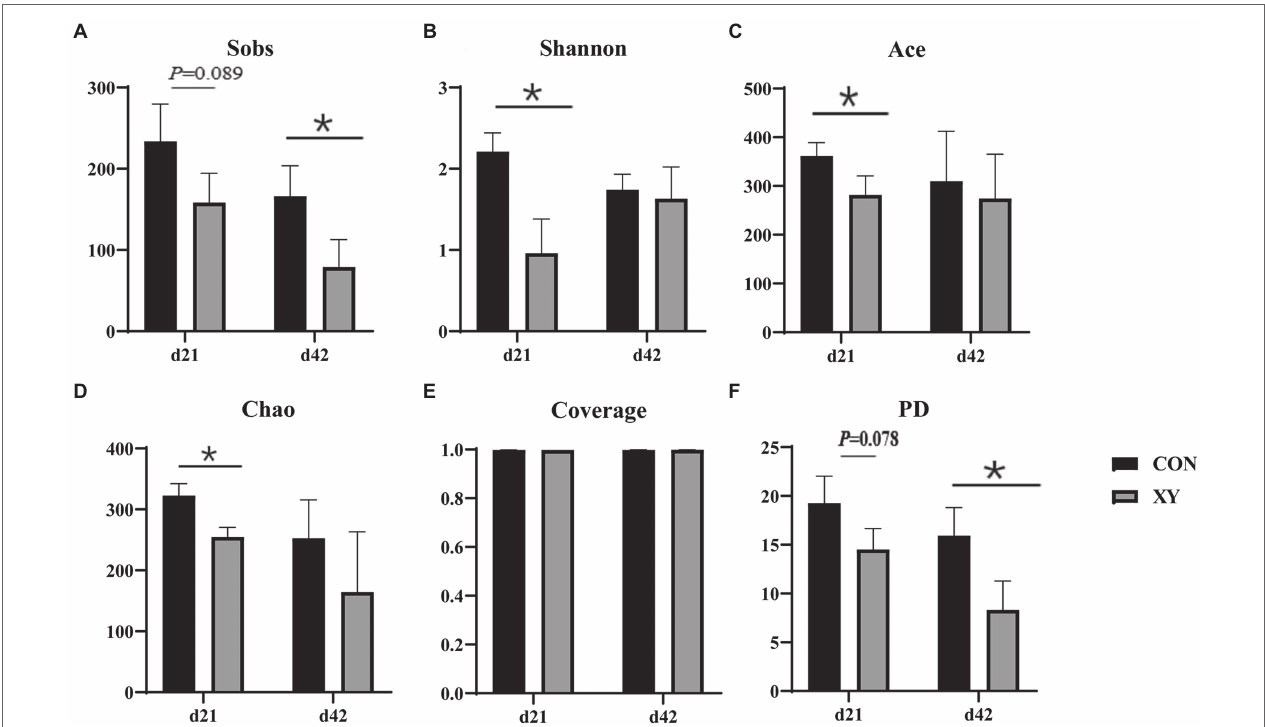
FIGURE 2 | Effects of AT-xynA on alpha diversity of ileal microbiota in broilers. (A) Observed richness (Sobs), (B) Shannon diversity index (Shannon), (C) ACE estimator (Ace) (D) Chao 1 estimator (Chao) (E) Good’s coverage (Coverage), and (F) phylogenetic diversity (PD) of ileal microbiota in broilers on days 21 and 42. CON is AT-xynA un-supplemented group; XY is 4,000 U/kg AT-xynA supplemented group. The “*” indicates a significant difference between the two treatments ( p <